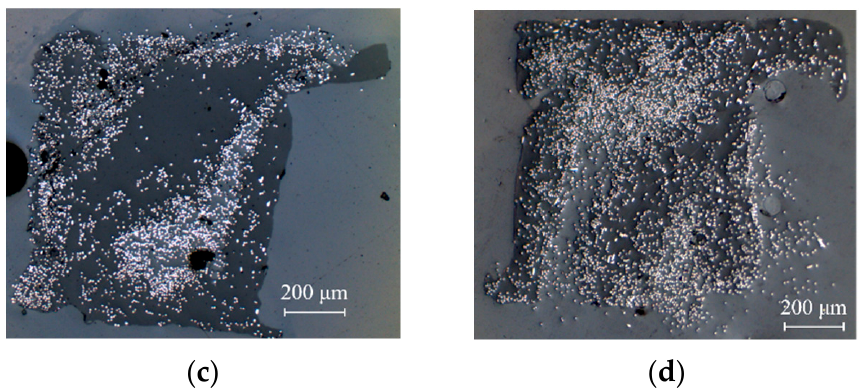
Figure 2. Square filament after passing through the rollers: ( a ) folding of tape with poor bonding; ( b ) microvoids in the filament; ( c , d ) material overflow at the corners. To shape the filament cross section into a circular shape, the square filament